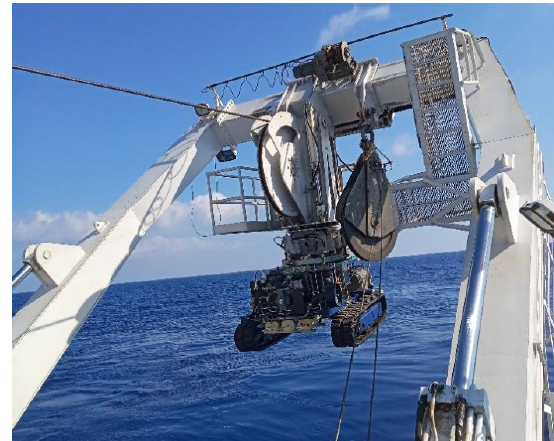
Figure 11. Launch and recovery system of the mining vehicle. The umbilical connects the vessel and the vehicle and contains six power cables and four fiber cables inside. The rated voltage is 3300 V, and the power is 70 kW. The outer diameter is 21.21 mm, the paid load is 56.6 kN, and the maximum operation depth is 6000 m.